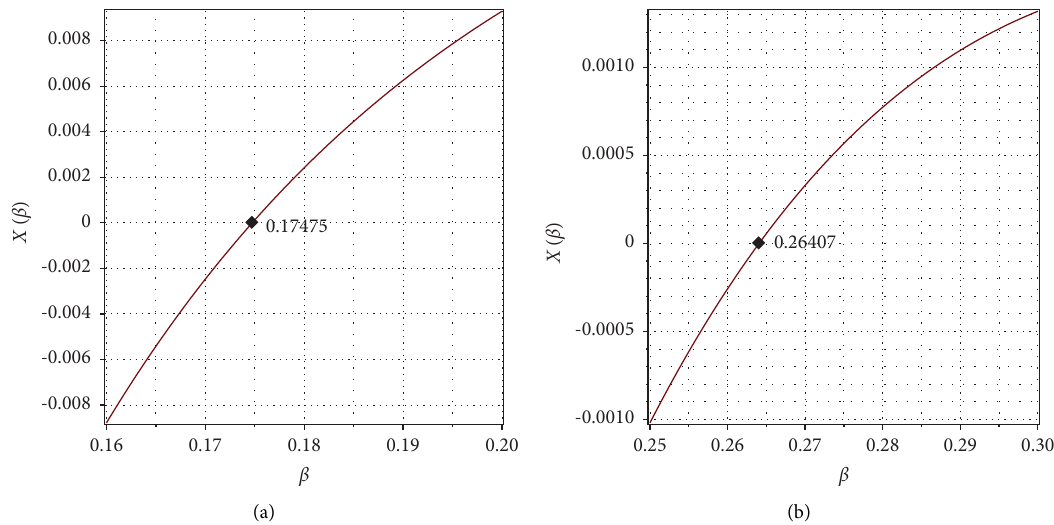
Figure 3: Evolution of χ ( β ) versus β with parameter values (26) and α � 0 . 952.